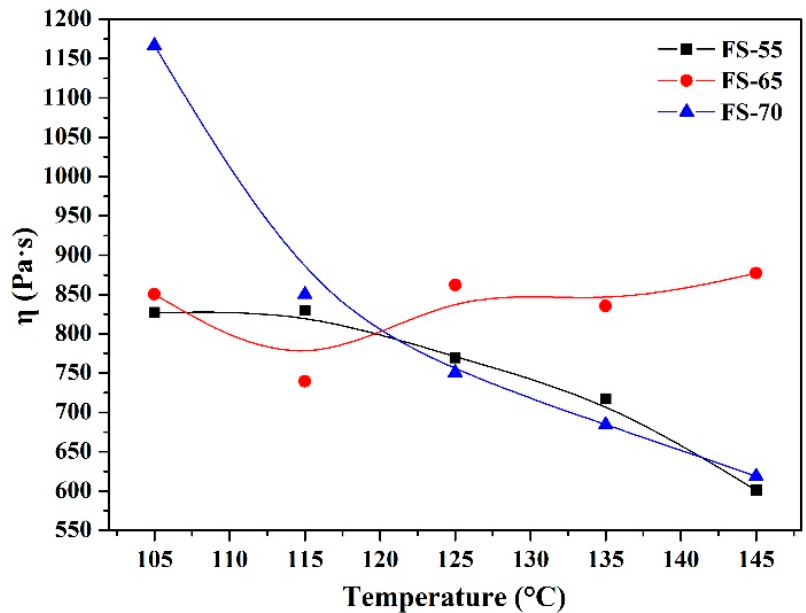
Figure 4. Viscosity changing with temperature at shearing rate of 178.8 s − 1 . The correlation between viscosity and temperature can be conveyed by Arrhenius-type formula [13]: